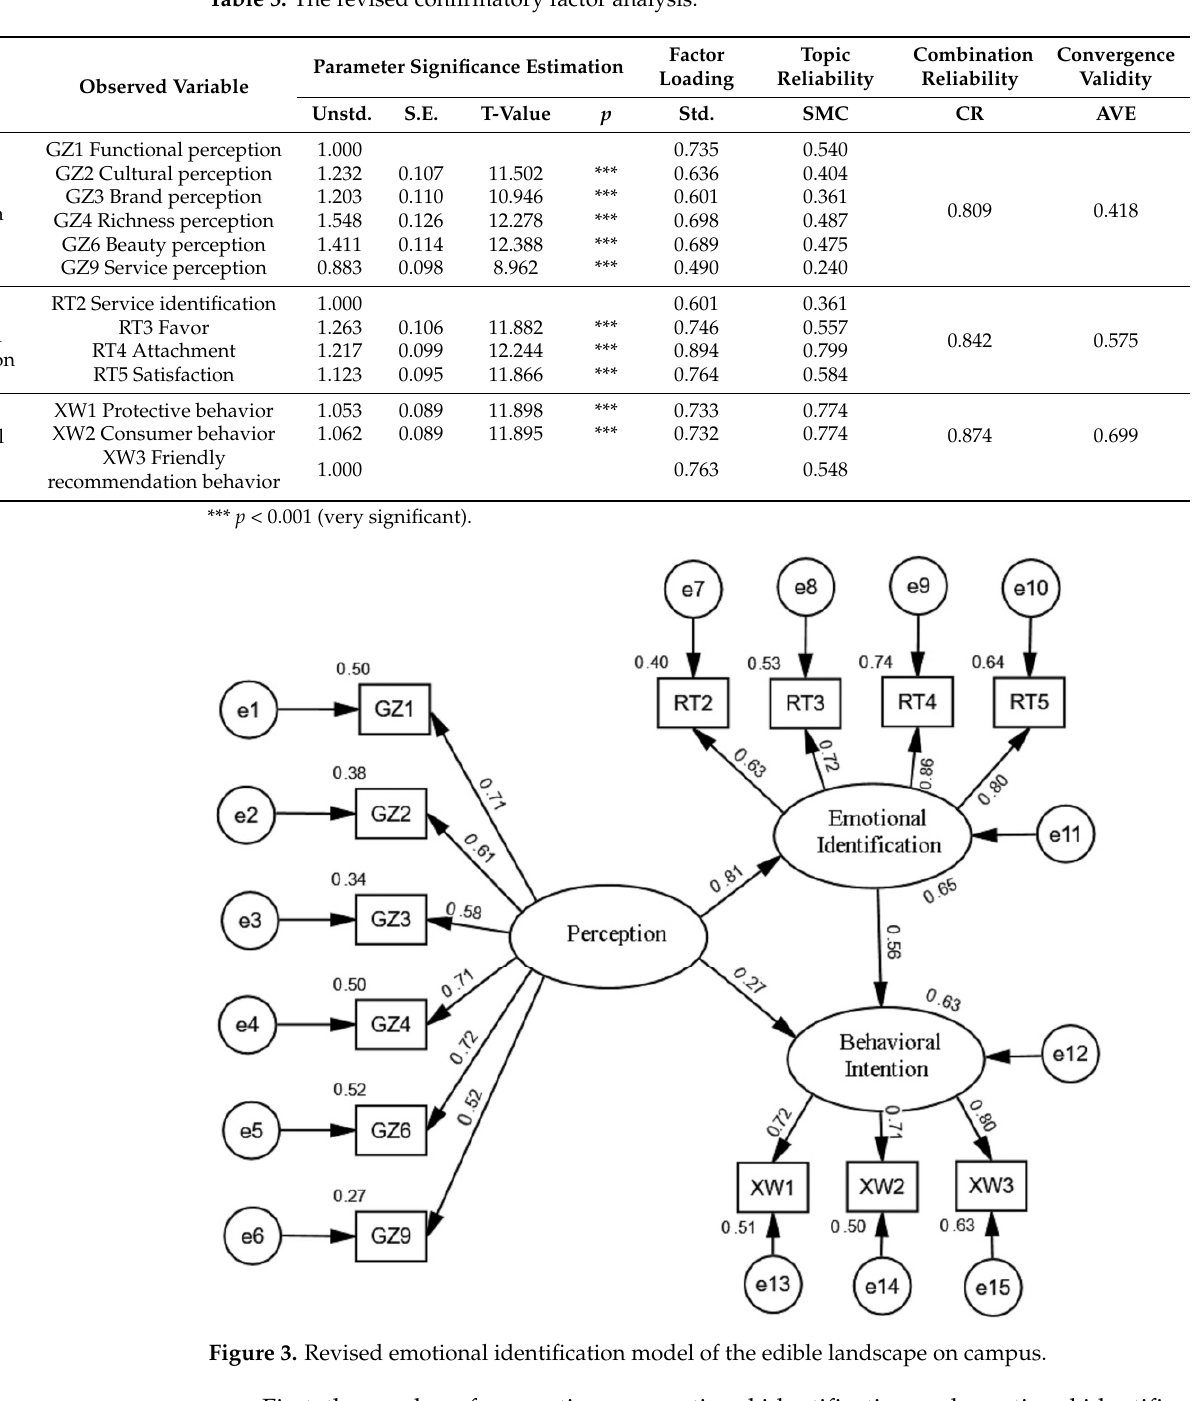
Figure 3. Revised emotional identification model of the edible landscape on campus.